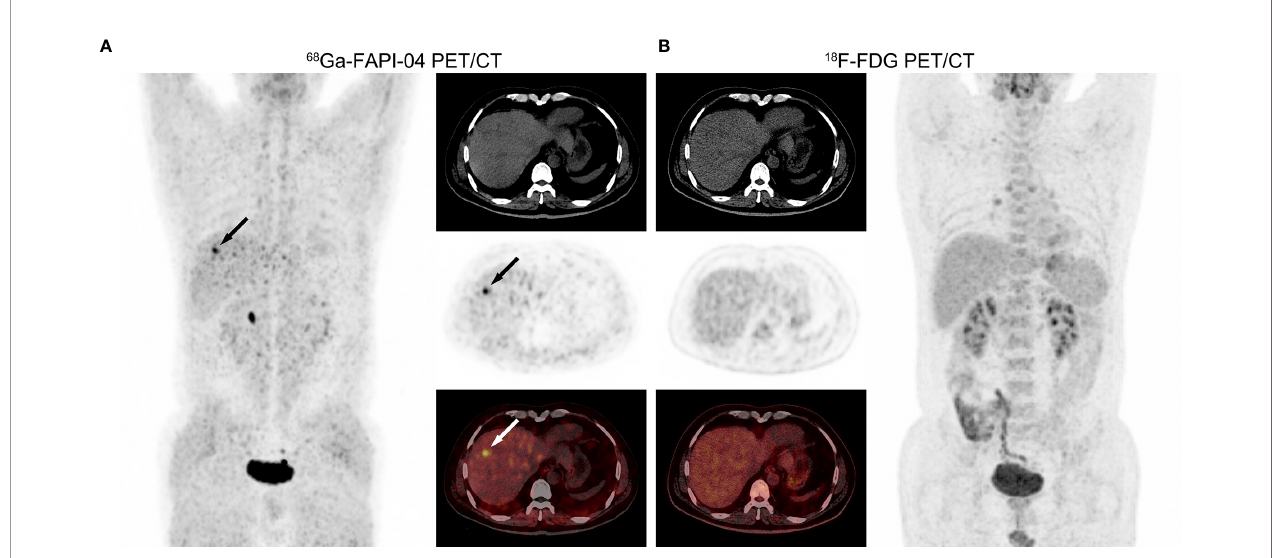
FIGURE 2 | PET/CT images in a 53-year-old male patient with moderately-differentiated HCC. (A) 68 Ga-FAPI-04 PET/CT revealed a strongly FAPI-avid lesion (black and white arrows, SUV max = 7.36, TBR = 6.03) in the right lobe of the liver. (B) No positive fi nding was observed within liver in 18 F-FDG PET/CT images (SUV max = 2.36, TBR = 1.31).